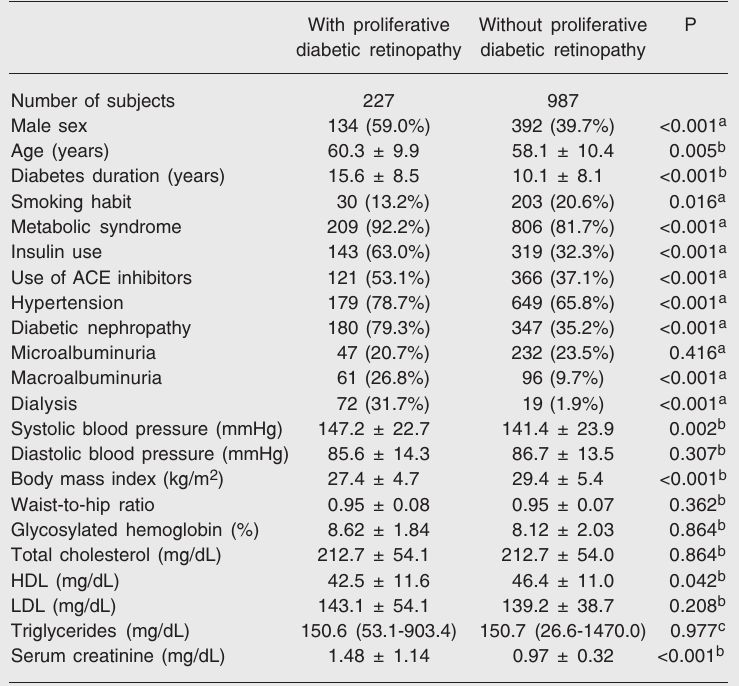
Table 1. Clinical and laboratory characteristics of 1214 type 2 diabetic patients with and without proliferative diabetic